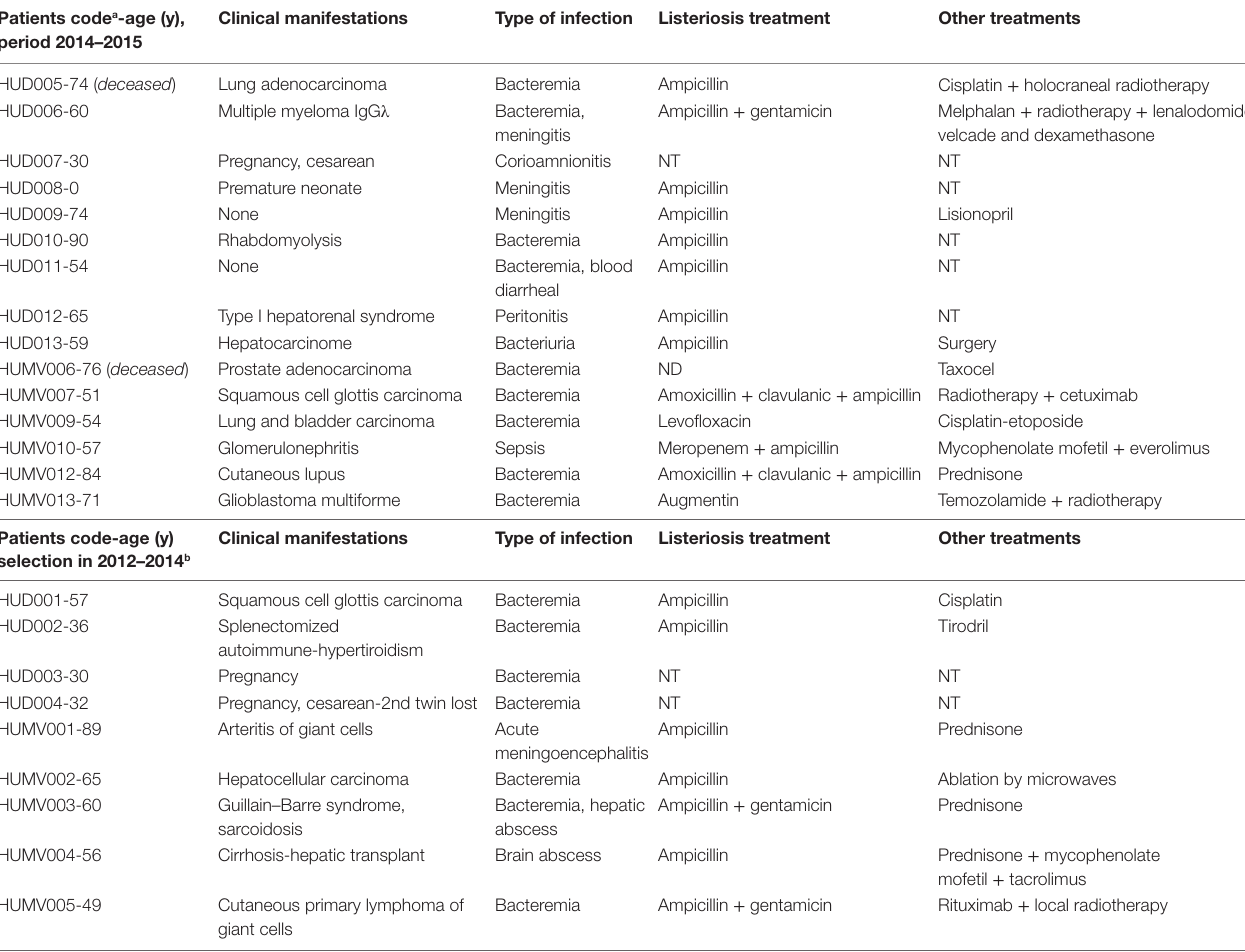
taBLe 1 | Listeriosis patients: clinical manifestations and treatments. patients code a -age (y), period